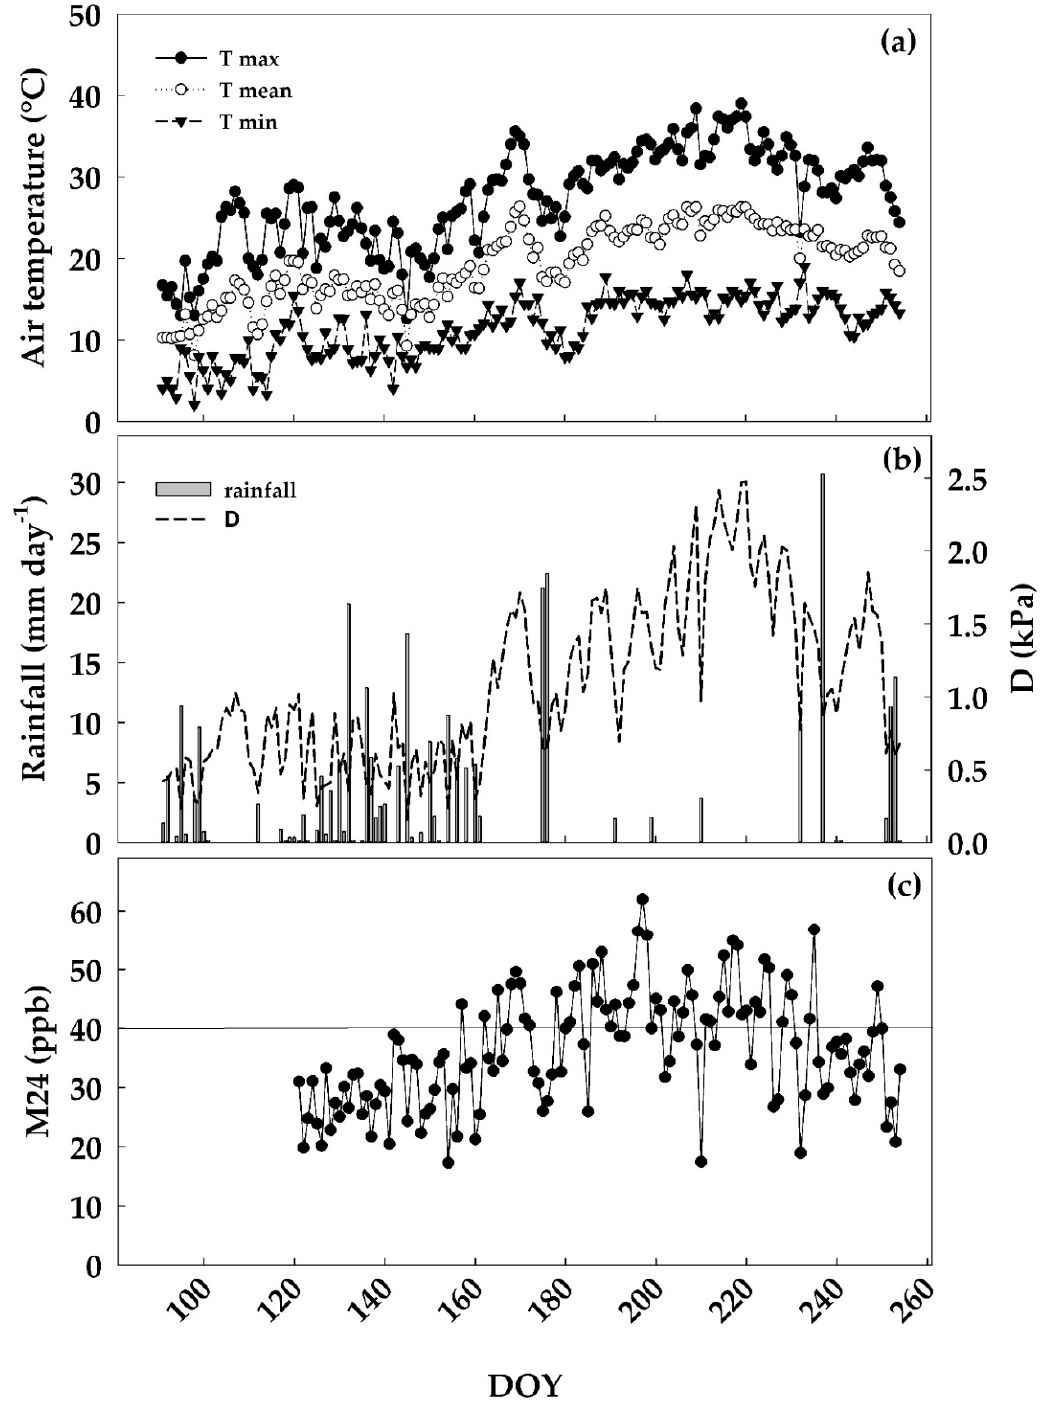
Figure 1. Time course of meteorological parameters from DOY 90 to DOY 256 at the experimental site: ( a ) daily minimum, mean and maximum air temperature; ( b ) daily rainfall and vapour pressure deficit (D); ( c ) 24-h daily average (M24) of hourly O 3 concentration. The horizontal line represents the threshold value of 40 ppb M24.